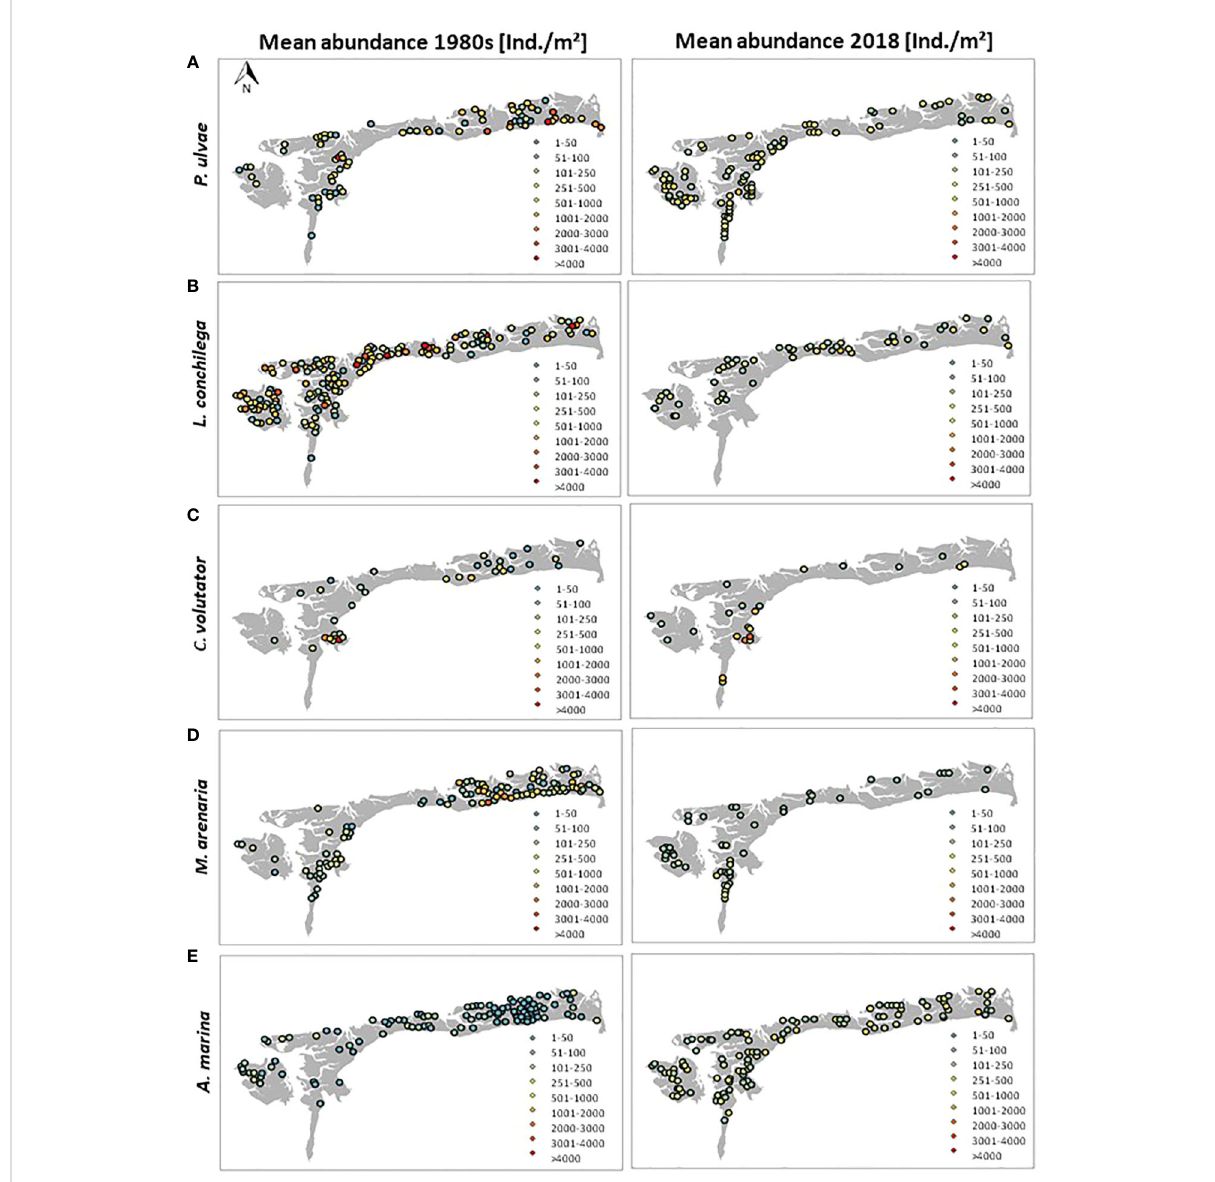
FIGURE 5 Overview of the spatial distribution of 5 dominant species showing most signi fi cant abundance decreases (A-D) and abundance increases (E) in the East-Frisian Wadden Sea (EFWS, 1980s versus